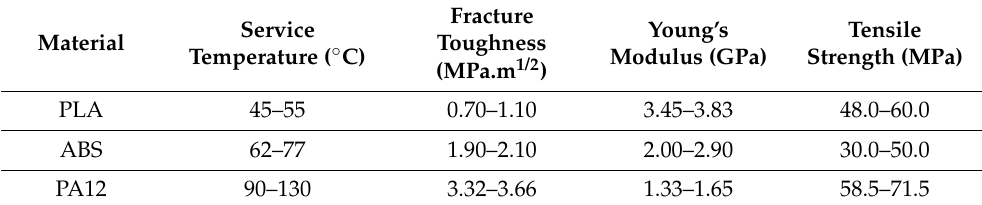
Table 1. Temperature, fracture toughness, and Young’s modulus of PLA, ABS, and PA12 (CES 2013 Edupack).